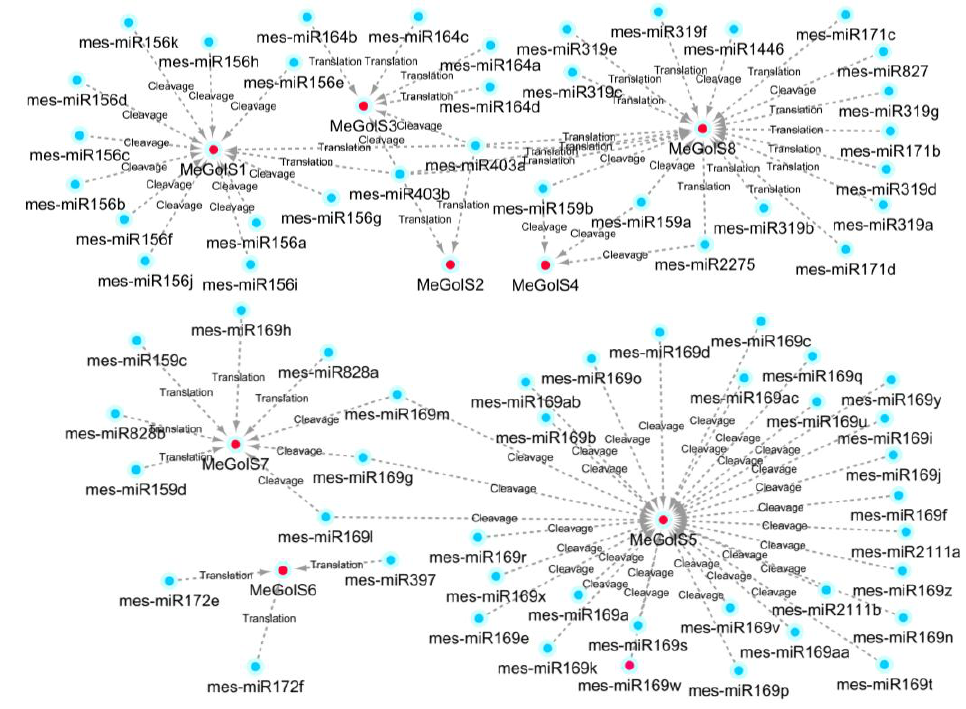
Figure 6. Prediction of microRNA targeting MeGolS genes.